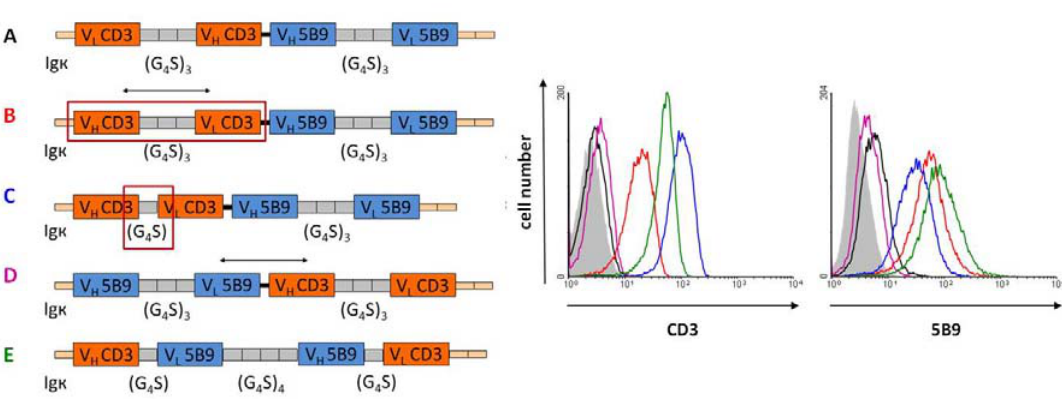
) and light (V ) chain domains as well as the linker H L S: block of four 4